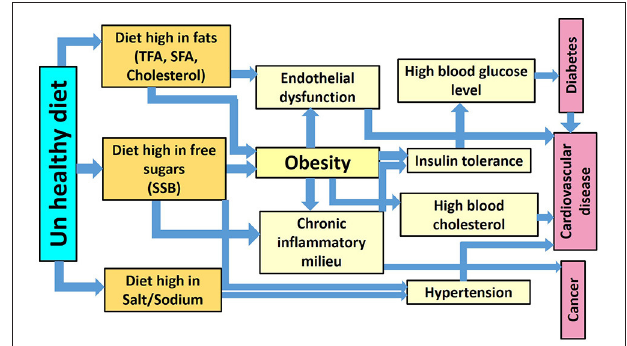
FIGURE 1 | The interdisciplinary relationship between unhealthy diet consumption, obesity, and other NCDs risk factors.